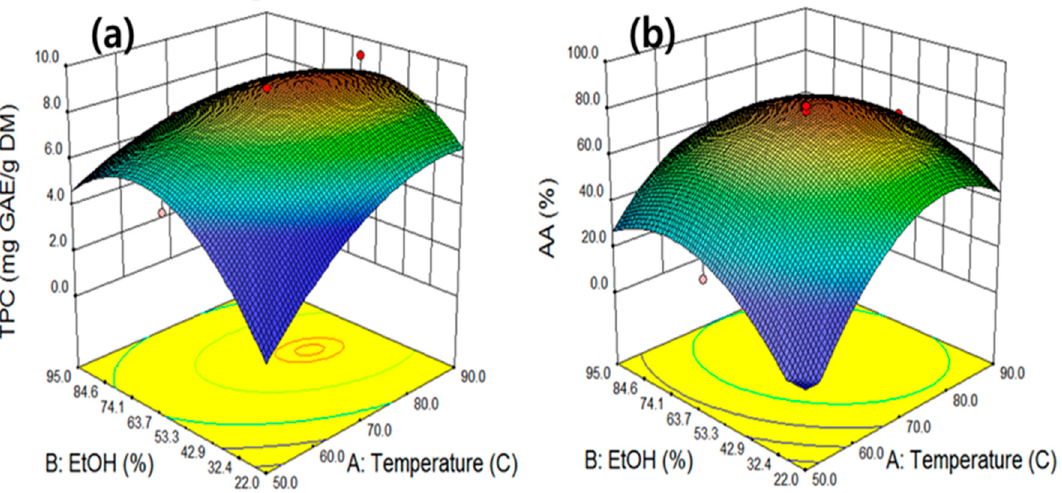
Figure 2. The interactive effects of the extraction temperature and ethanol concentration on total phenolic compounds ( a ) and antioxidant activity ( b ) at fixed levels of extraction time 45 min and ultrasonic power 500 W.